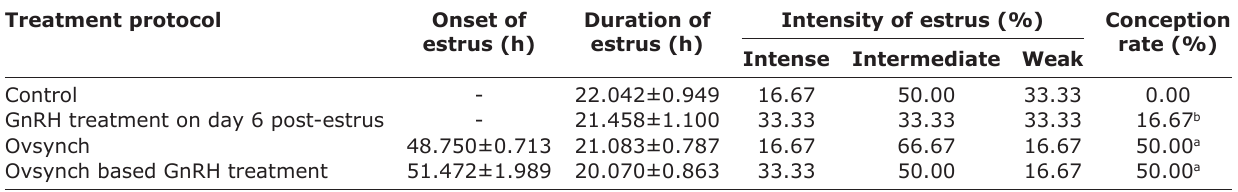
Table-2: Natural and induced estrus response in repeat breeding crossbred cows of treatments and control group. Treatment protocol Onset of estrus (h) Control